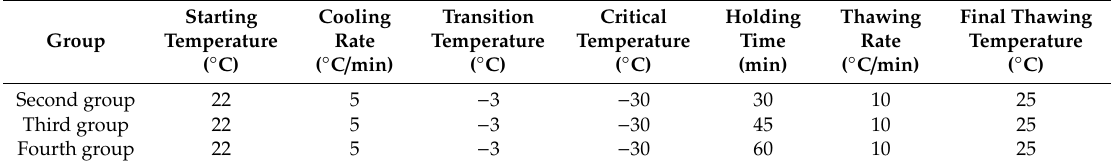
Table 3. Experimental scheme at di ff erent holding times.